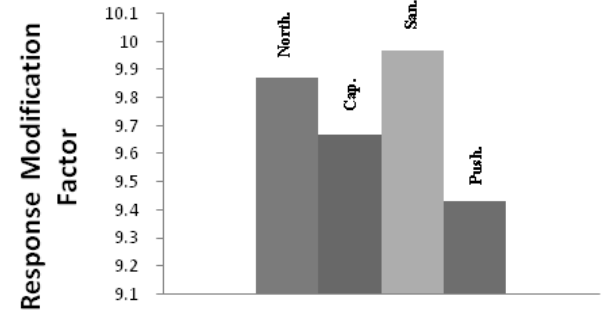
Fig. 10. Comparison of the response modification factors due to different records